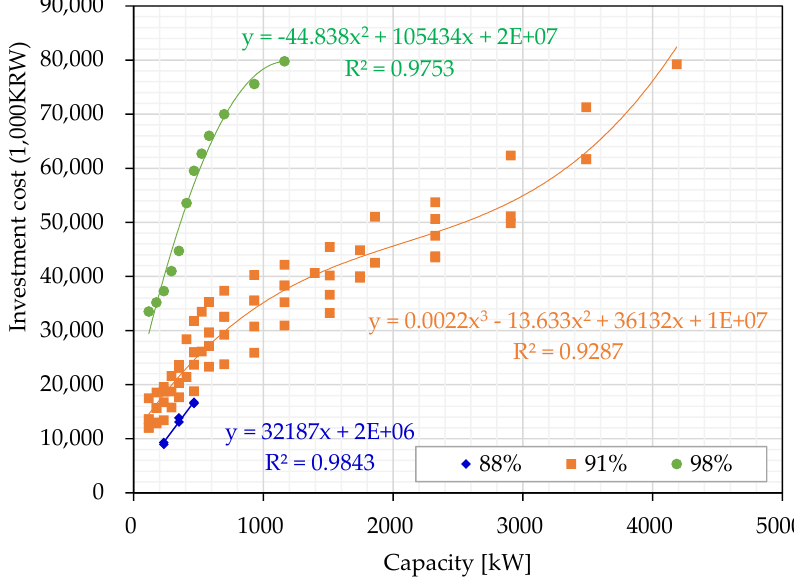
Figure 2. Relationships between the capacity by efficiency and investment cost of boiler.